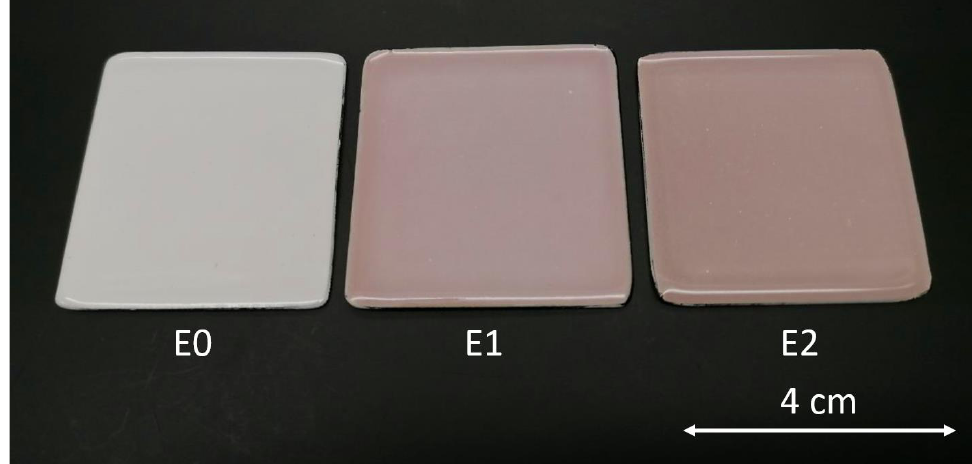
Figure 2. Top view of the enameled samples (40 mm × 40 mm). E0 (reference samples), E1 (admixed with 1% wt. AgNO 3 ), and E2 (admixed with 2% wt. AgNO 3 ). with 1% wt. AgNO 3 ), and E2 (admixed with 2% wt. AgNO 3 ).